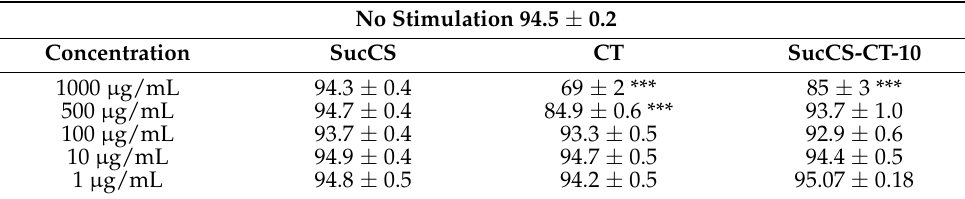
Table 3. Viability of THP-1 cells after 24 h in vitro co-cultivation with SucCS-CT conjugate. Data are presented as mean ± SD ( n ≥ 6); the data are shown as the percentages of viable cells. No Stimulation 94.5 ± 0.2